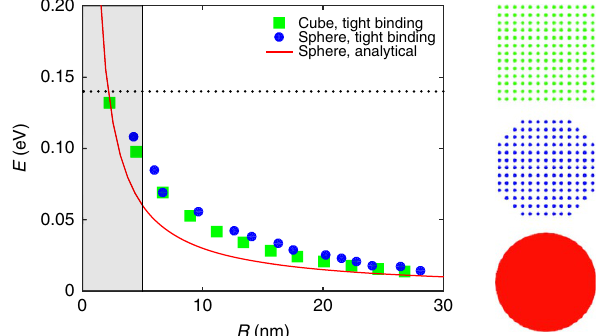
Figure 2 | Surface states obtained with different methods. Energy of the first surface state above the Dirac point calculated with a tight-binding model for cubic (green squares) and spherical (blue circles) particles compared with analytical results (red curve). Models are illustrated on the side. Good agreement between the energies of spherical and cubic (edge size R ffiffiffiffiffiffiffiffiffiffiffi 4 p = 3 3 p ) particles is due to topological nature of the surface states. The horizontal dotted line denotes the bulk band gap and the shaded region is where the model breaks down. Subsequent calculations use R 4 10nm where model shows good validity.